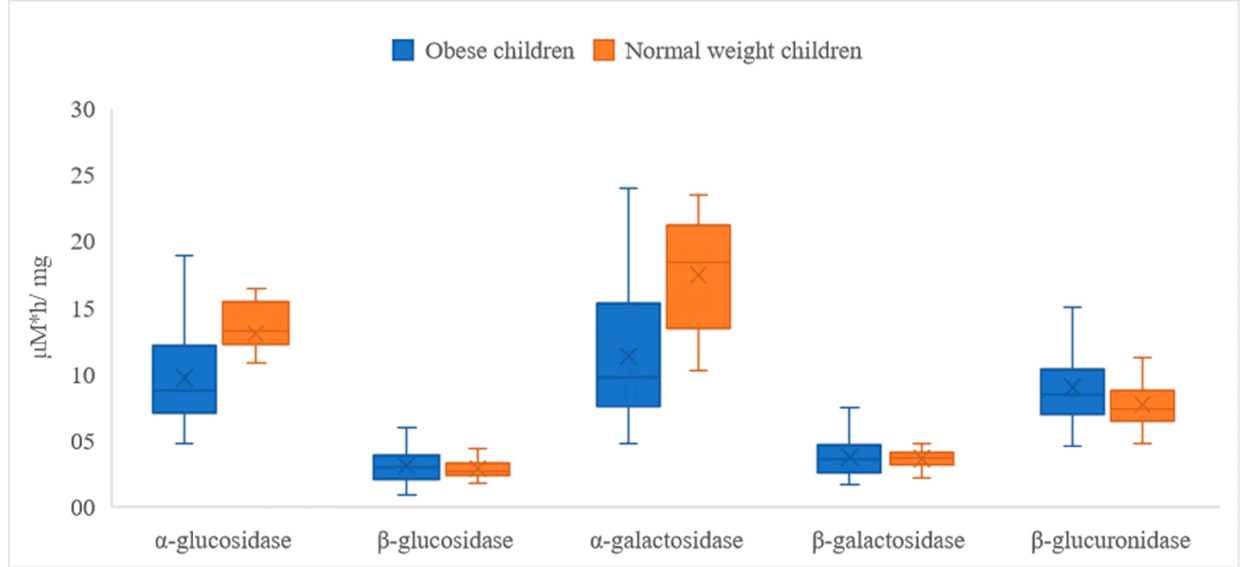
Figure 3. Activity of fecal enzymes in obese versus normal-weight children.